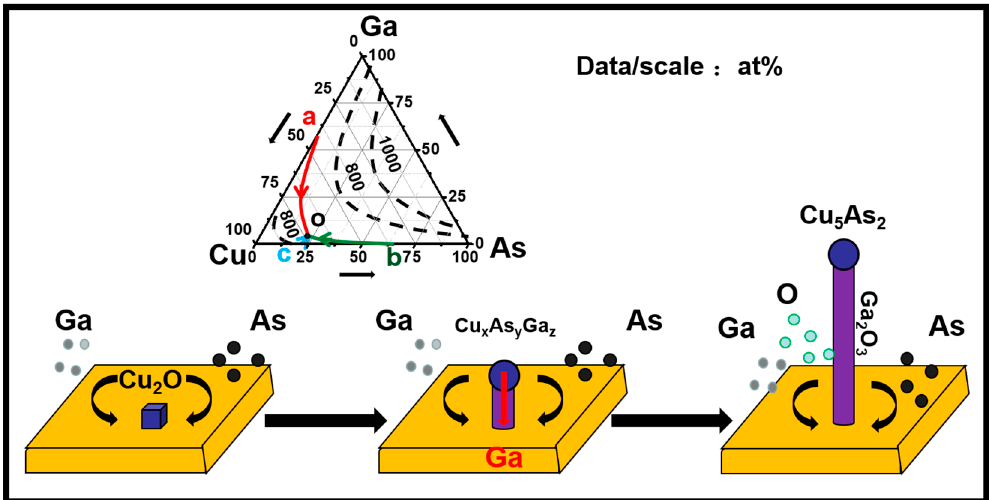
Figure 6. Schematic illustration of the β -Ga 2 O 3 NWs growth process. The Cu 2 O nano cube catalysts first decomposes to form Cu droplets, which then absorb Ga and As precursors to form a Cu x As y Ga z catalyst alloy. The Ga precursors then diffuse through the alloy and then react with residual oxygen to form the NWs. Above the picture is the Cu-As-Ga ternary alloy phase diagram. The red, green, and blue curves represent the alloy wire lines, and the dotted lines are the temperature curves. The eutectic point can be clearly seen in the diagram to form the Cu 5 As 2 alloy phase.